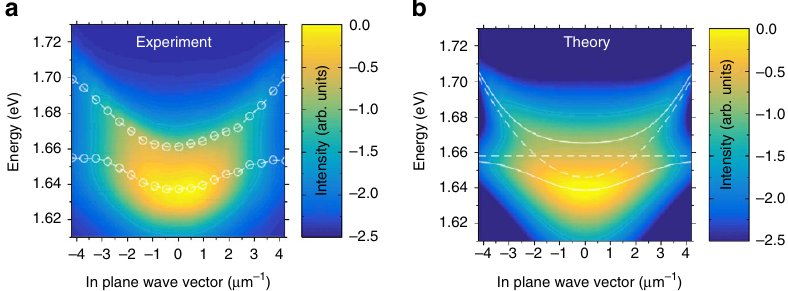
Figure 3 | Experimental and theoretical polariton dispersion relations in the studied Tamm structure. ( a ) Room-temperature false colour intensity profile of the full polariton dispersion relation extracted from the PL measurements. ( b ) Model of the full dispersion by assuming a Boltzmann distribution of the quasiparticles with an effective temperature of and energy, and k B is the Boltzmann constant. The modelled PL is the photonic Hopfield coefficients via: thus generated by a polariton gas at room temperature ( T ¼ 300 K). We further assume that the emission stems from the photonic mode only and is broadened in energy according to a Lorentz distribution. This allows us to relate the PL intensity to